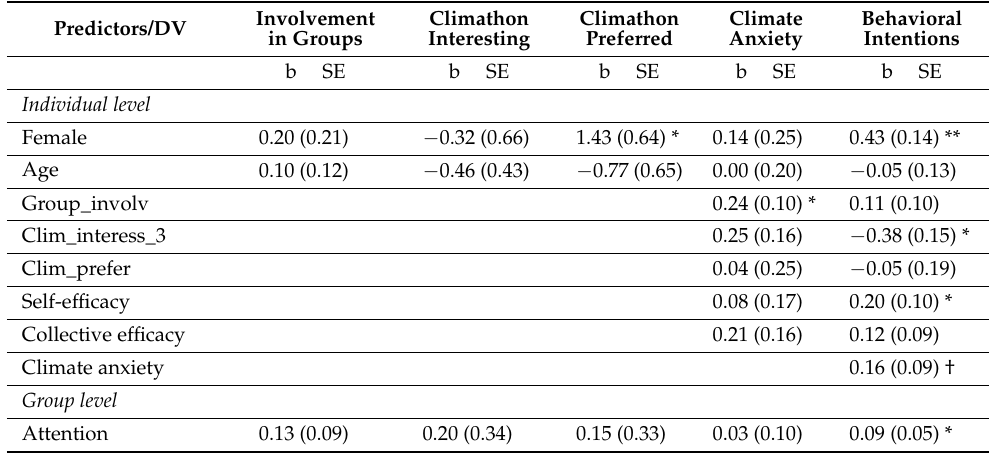
Table A4. Results of multilevel regressions, with the score of perceived attention as group-level predictor.